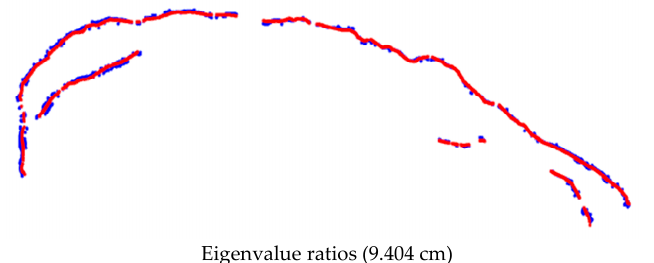
Figure 15. The discrepancies between the ground truth (red) and the extracted landslide scarp data collected using the data collected in May 2014 (blue).